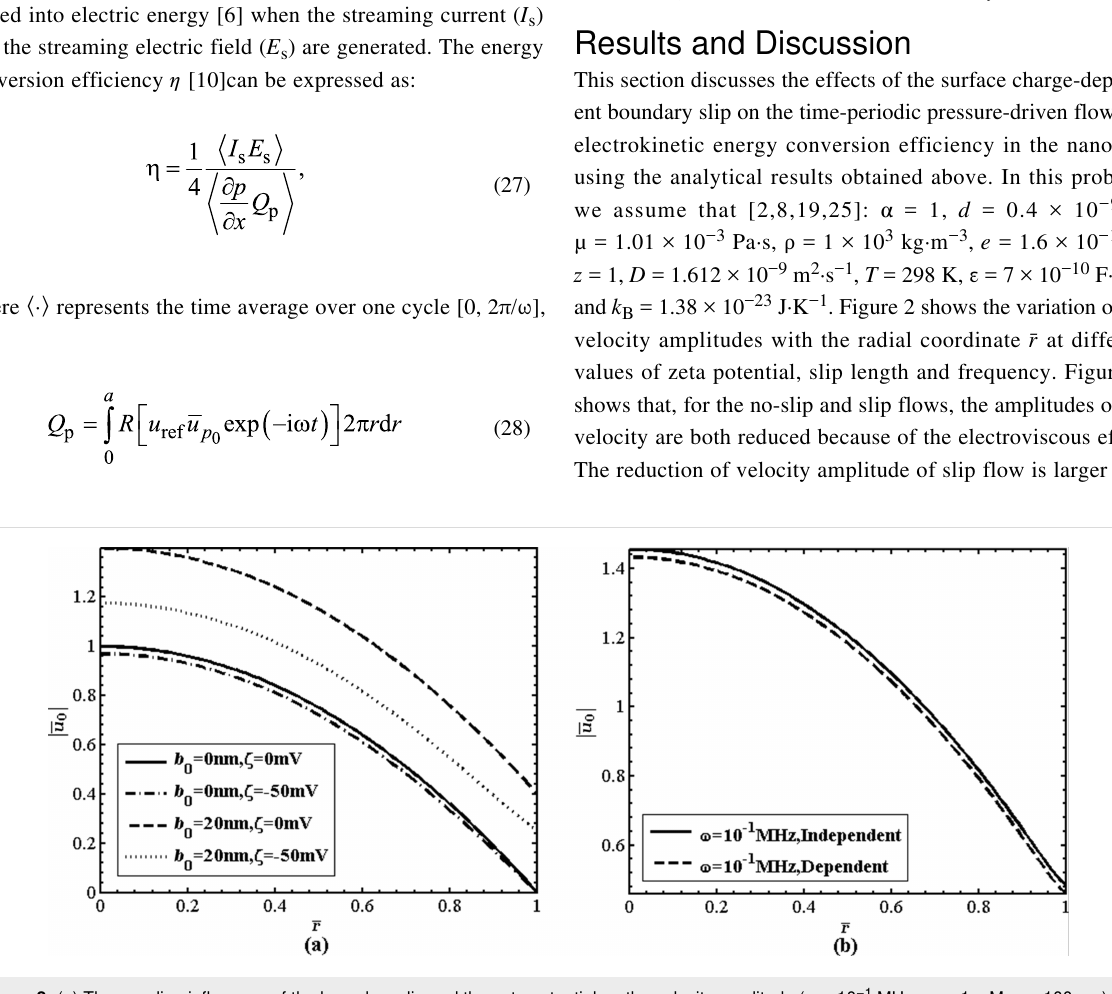
Figure 2: (a) The coupling influences of the boundary slip and the zeta potential on the velocity amplitude ( ω = 10 − 1 MHz, n 0 = 1 mM, a = 100 nm); (b) Comparison between the velocity amplitude of the surface charge-dependent slip flow and that of the surface charge-independent slip flow ( ζ = − 50 mV, b 0 = 20 nm, n 0 = 100 mM, a = 37.5